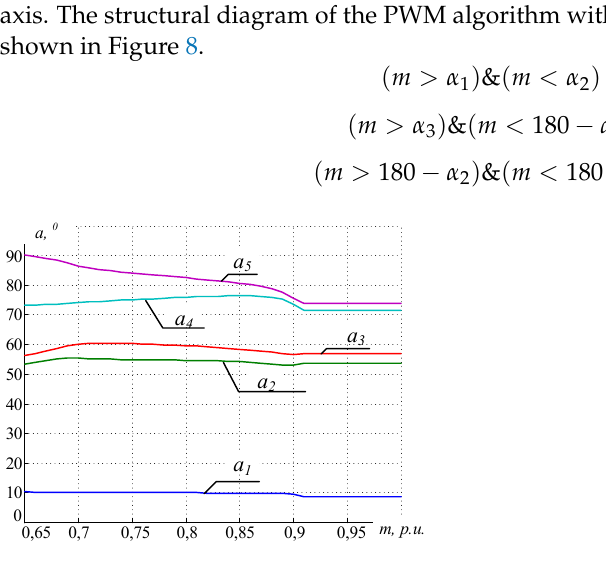
Figure 7. The dependency of the switching angles and the modulation coefficient.